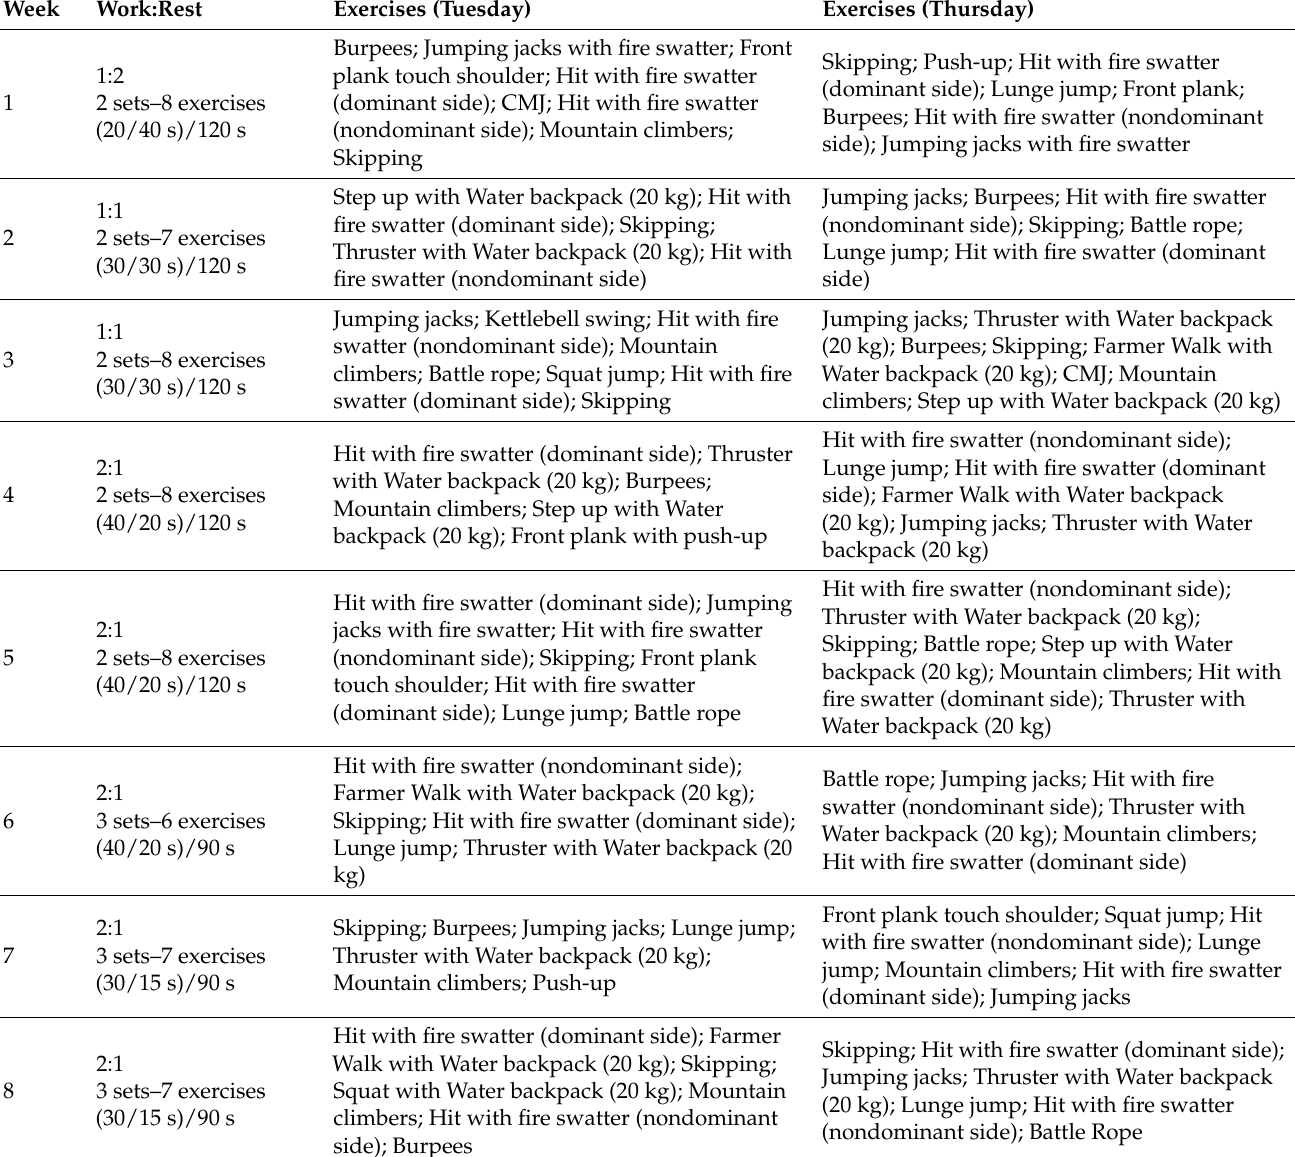
Table 1. High-intensity circuit training